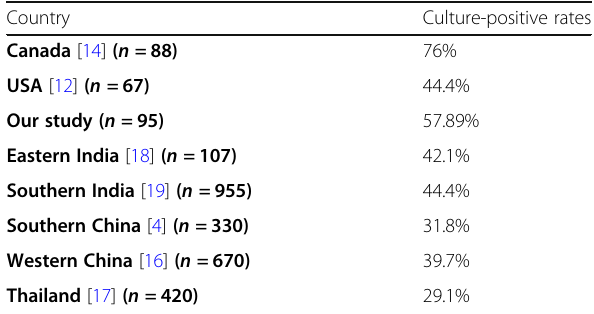
Table 7 Culture-positivity compared to other studies. Our culture-positivity rate was higher compared to other Asian countries as well as the USA, but lower than in